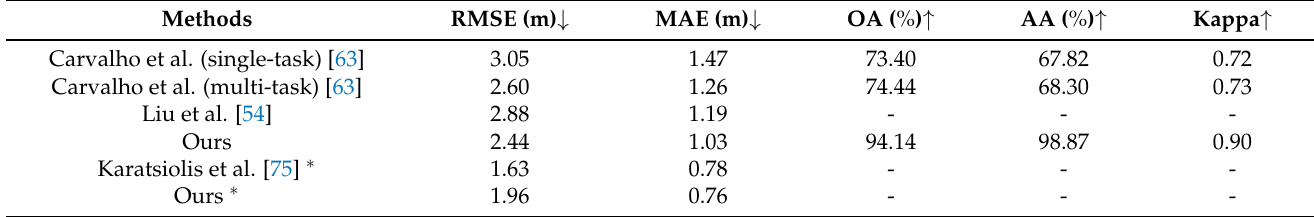
Table 4. Comparison of the results of current main methods in DFC2018